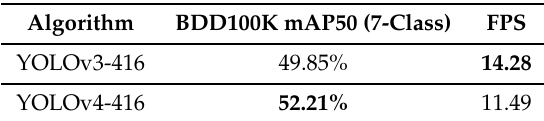
Table 5. Detection quality (mAP50) and throughput (FPS) with YOLOv3 and YOLOv4 models